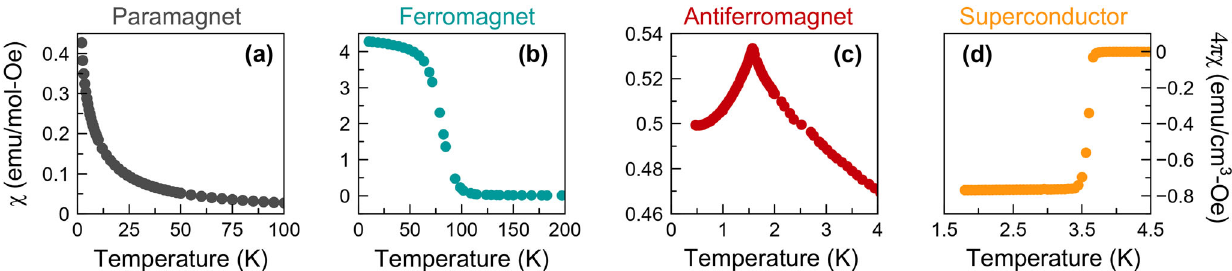
Fig. 2 Examples of ordering transitions in magnetic susceptibility. Magnetic susceptibility measurements are sensitive to the presence (or absence) of long-range ordering transitions. a Materials with dilute magnetic moments may remain paramagnetic down to the lowest temperatures, such as this reproduced data set for dilute Mn 2 + moments in SrMn 1/2 Te 3/2 O 6 64 . b Ferromagnetic (and ferrimagnetic) transitions are marked by a sharp increase in the susceptibility as the moments align with the external fi eld, as shown for Ni 0.68 Rh 0.32 with T C = 96 K 65 . c Antiferromagnetic transitions are marked by a sharp cusp in the susceptibility, as shown for Gd 2 Pt 2 O 7 with T N = 1.6 K 66 . d Superconducting transitions are marked by an abrupt decrease in